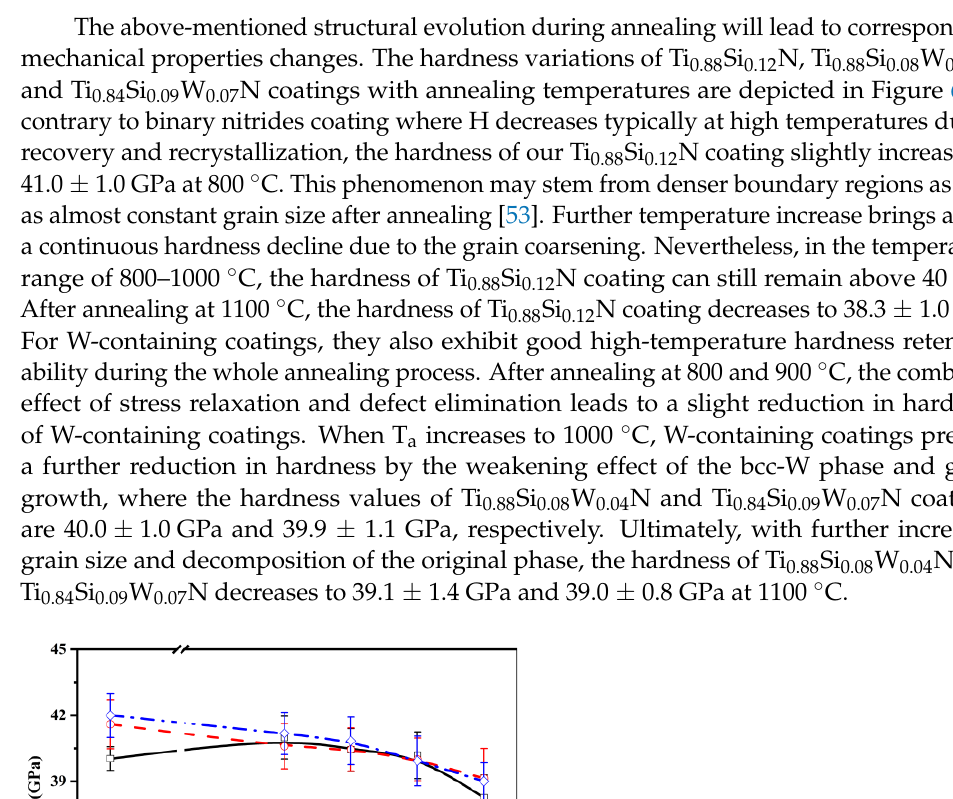
Figure 5. XRD diffractograms of ( a ) Ti 0.88 Si 0.12 N, ( b ) Ti 0.88 Si 0.08 W 0.04 N, and ( c ) Ti 0.84 Si 0.09 W 0.07 N powdered coatings after annealing at indicated temperatures.